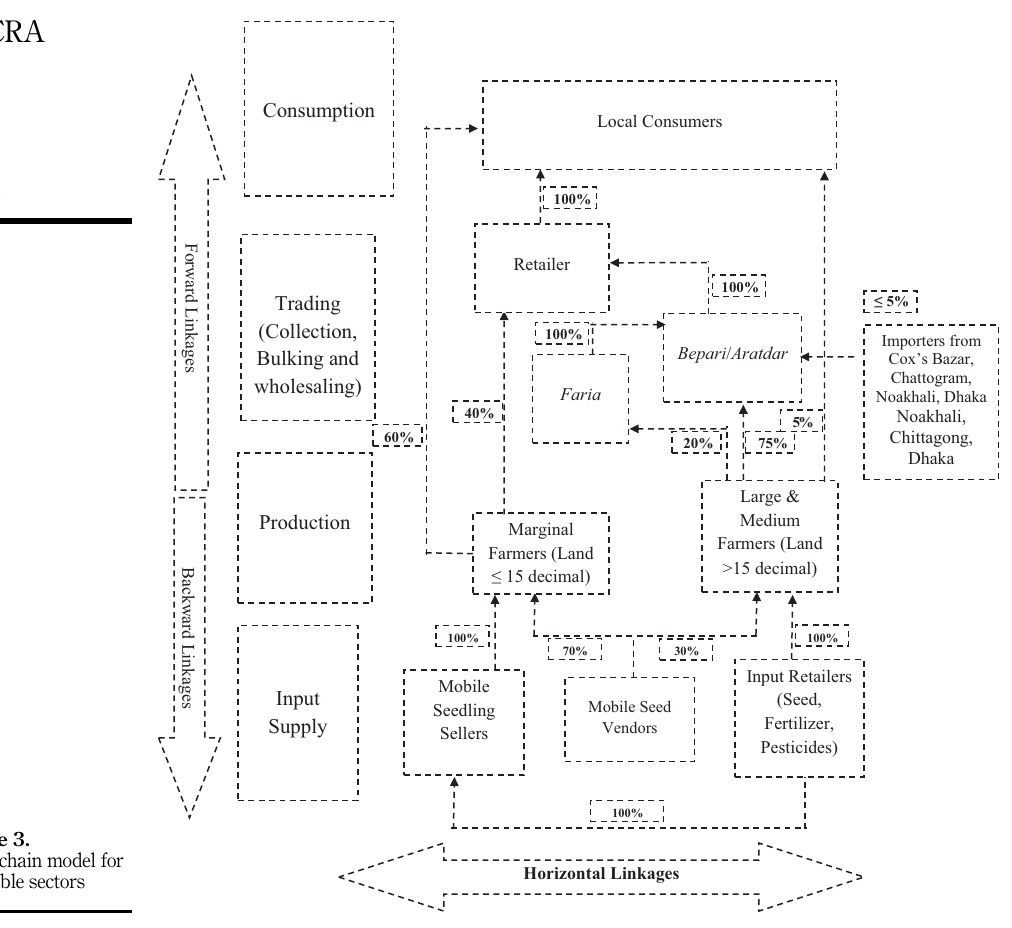
Figure 3. Value chain model for vegetable